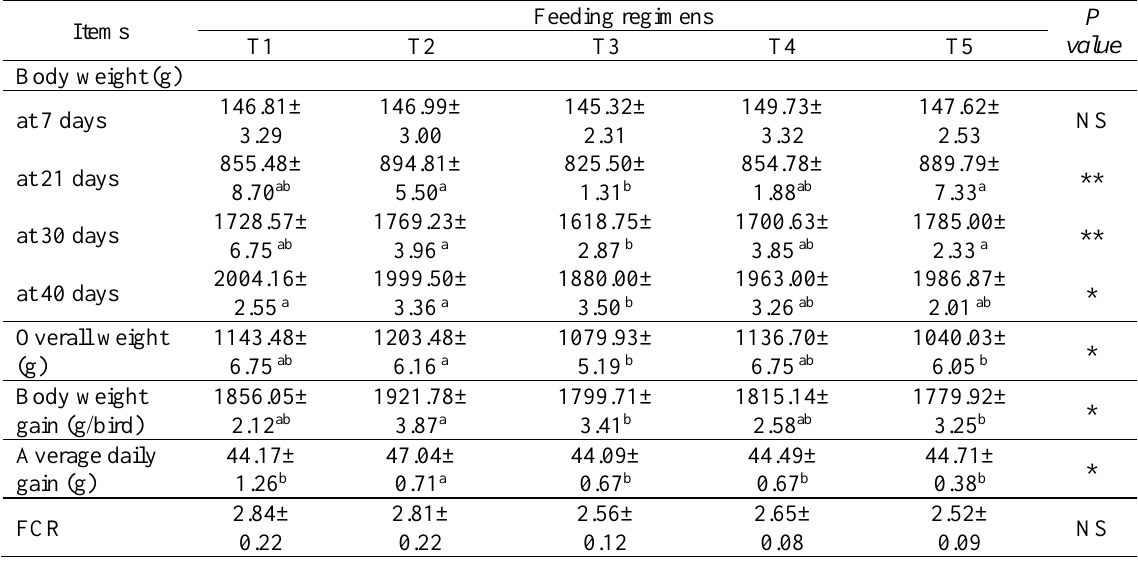
Feeding regimens P